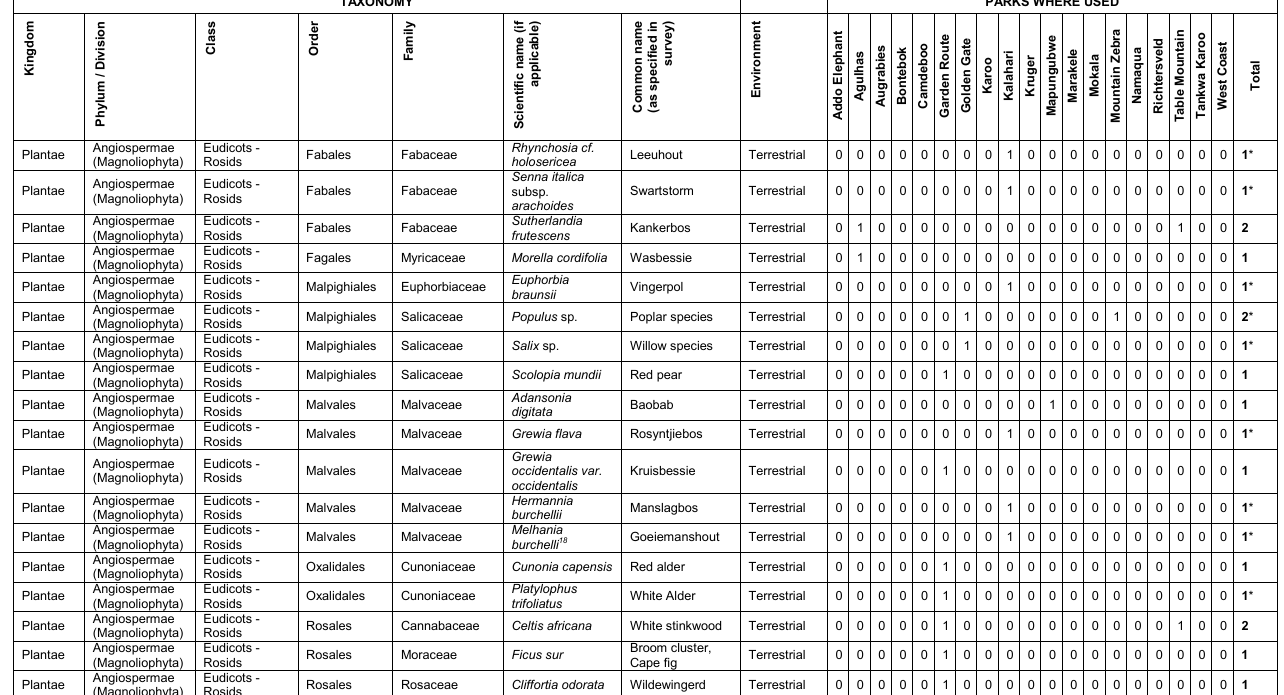
Sapindales Anacardiaceae Searsia chirindensis Angiospermae Eudicots - Ekebergia (Magnoliophyta) Rosids Sapindales Meliaceae capensis Cape Ash Agathosma betulina x Sapindales Rutaceae Agathosma crenulata hybrid Sapindales Rutaceae Agathosma sp. Angiospermae Eudicots - Calodendrum (Magnoliophyta) Rosids Sapindales Rutaceae capense Cape Chestnut Sapindales Rutaceae Clausena anisata Perdepis Plantae Angiospermae (Magnoliophyta) Eudicots - Rosids Sapindales Rutaceae Coleonema sp. Buchu spp Plantae Angiospermae (Magnoliophyta) Eudicots - Rosids Sapindales Rutaceae Diosma sp. Plantae Angiospermae (Magnoliophyta) Eudicots - Rosids Sapindales Rutaceae Empleurum unicapsulare Buchu Plantae Angiospermae (Magnoliophyta) Eudicots - Rosids Sapindales Rutaceae Various species Breeblaar boegoes Plantae Angiospermae (Magnoliophyta) Eudicots - Rosids Sapindales Rutaceae Vepris lanceolata White ironwood Plantae Angiospermae (Magnoliophyta) Magnoliids Canellales Canellaceae Warburgia salutaris Pepper bark tree Terrestrial Plantae Angiospermae (Magnoliophyta) Magnoliids Laurales Lauraceae Cinnamomum camphora Camphor tree Laurales Lauraceae Ocotea bullata Myrtaceae Eucalyptus sp. Eucalyptus, Gum tree Terrestrial Myrtaceae Metrosideros excelsa (?) Myrtle Plantae Angiospermae (Magnoliophyta) Magnoliopsida Myrtales Oliniaceae Olinia ventosa Hard pear Plantae Angiospermae (Magnoliophyta) Magnoliopsida Ranunculales Menispermacea e Cissampelos capensis